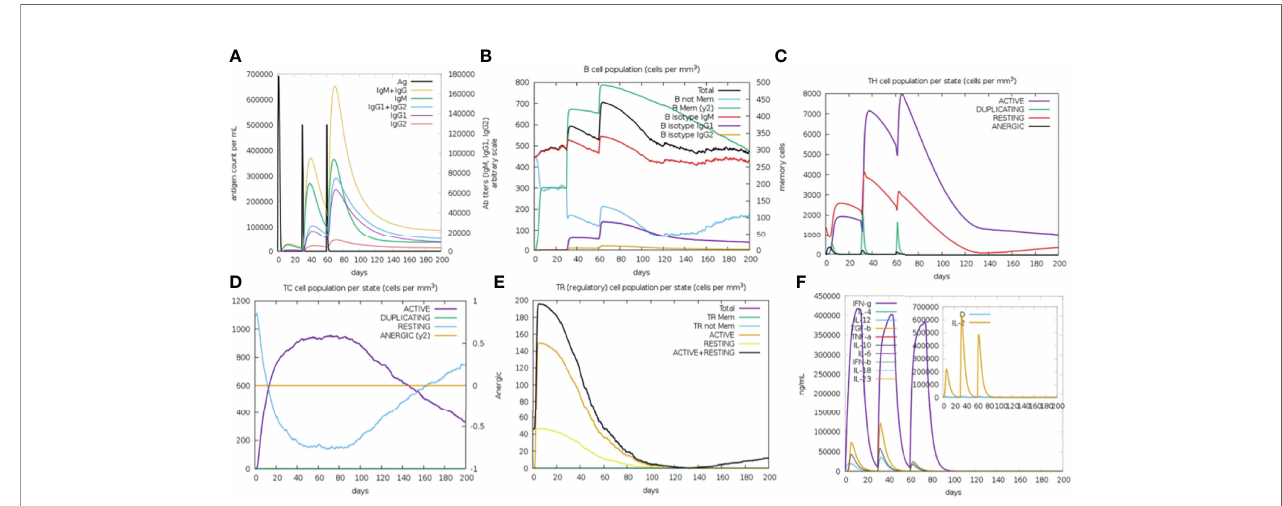
FIGURE 8 | Immune Simulation with the SMV4 vaccine candidate using C-ImmSim server. (A) Immunoglobulin production in response to antigen injections; speci fi c subclasses are showed as colored peaks. (B) B-cell populations after the three injections. (C) Generations of T-helper cells. (D) Generation of T-cytotoxic cell populations. The resting state characterizes cells not presented to the antigen, the anergic state indicates tolerance of the T-cells to the antigen. (E) Levels of T regulatory cells. (F) The main plot shows cytokine levels after the injections. The insert plot shows IL-2 level with the Simpson index, (D) shown by the dotted line. (D) is a measure of diversity. Increase in (D) over time indicates emergence of different epitope-speci fi c dominant clones of T-cells. The smaller the (D) value, the lower the diversity.